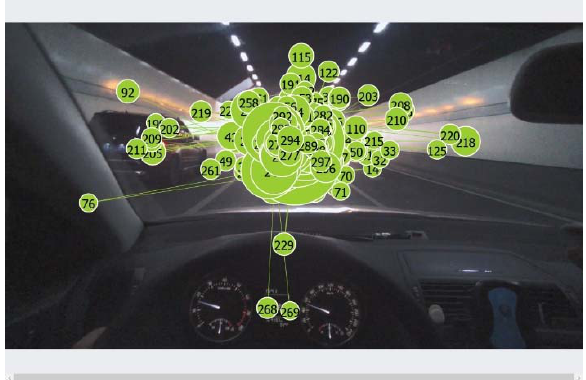
Figure 10. Distribution of driver fixation points in Xuanwuhu Tunnel.